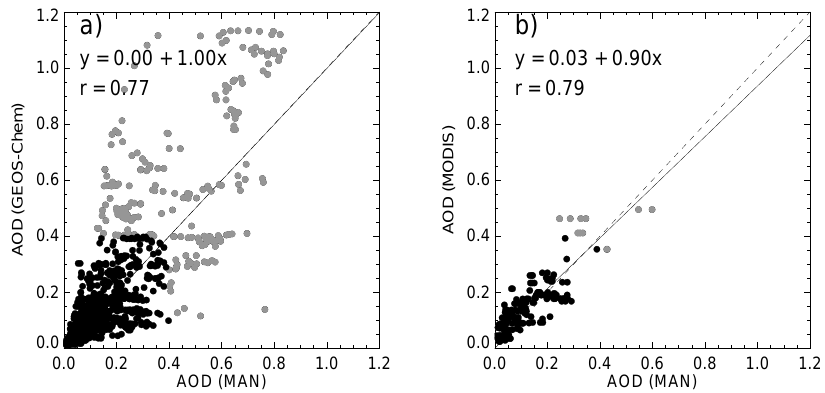
Fig. 4. Scatter plot of (a) modeled AOD and (b) MODIS AOD against sunphotometer measurements (MAN), sampled to coincide with MODIS overpass. Regression lines (solid black lines) are computed for datapoints with AOD < 0.4 (black dots) by the reduced major axis method (Ayers, 2001; Draper and Smith, 1998). A 1:1 line is also shown (dashed line). Datapoints with AOD > 0.4 are shown in